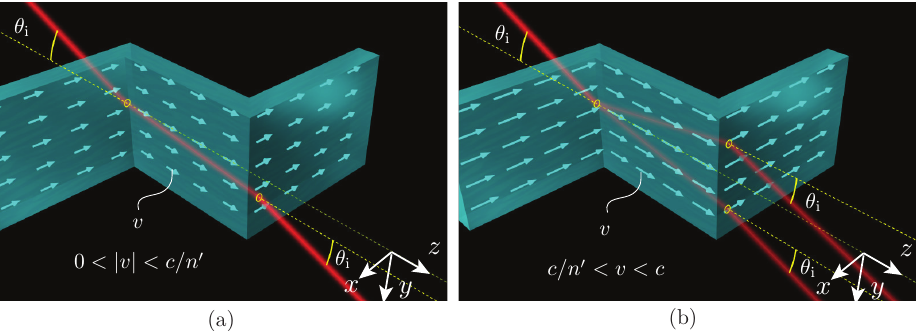
Figure 1. Wave scattering at a stationary interface between a simple (isotropic, dispersionless and linear) medium, such as air or a standard dielectric fluid, and a moving medium with uniform motion of velocity v perpendicular to the interface and rest refractive index (refractive index if the medium were at rest) n (cid:48) . ( a ) Subluminal regime (